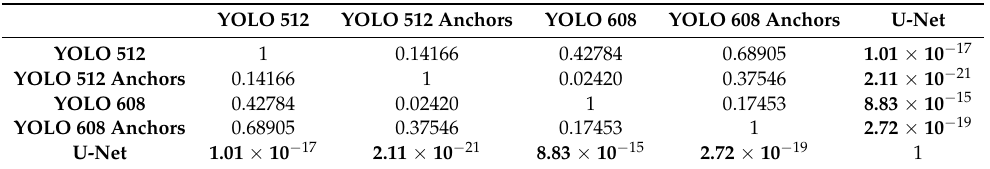
Table A3. McNemars’ test for fracture-based evaluation of the methods. Bolded values represent statistical significance at the p < 0.01 level.